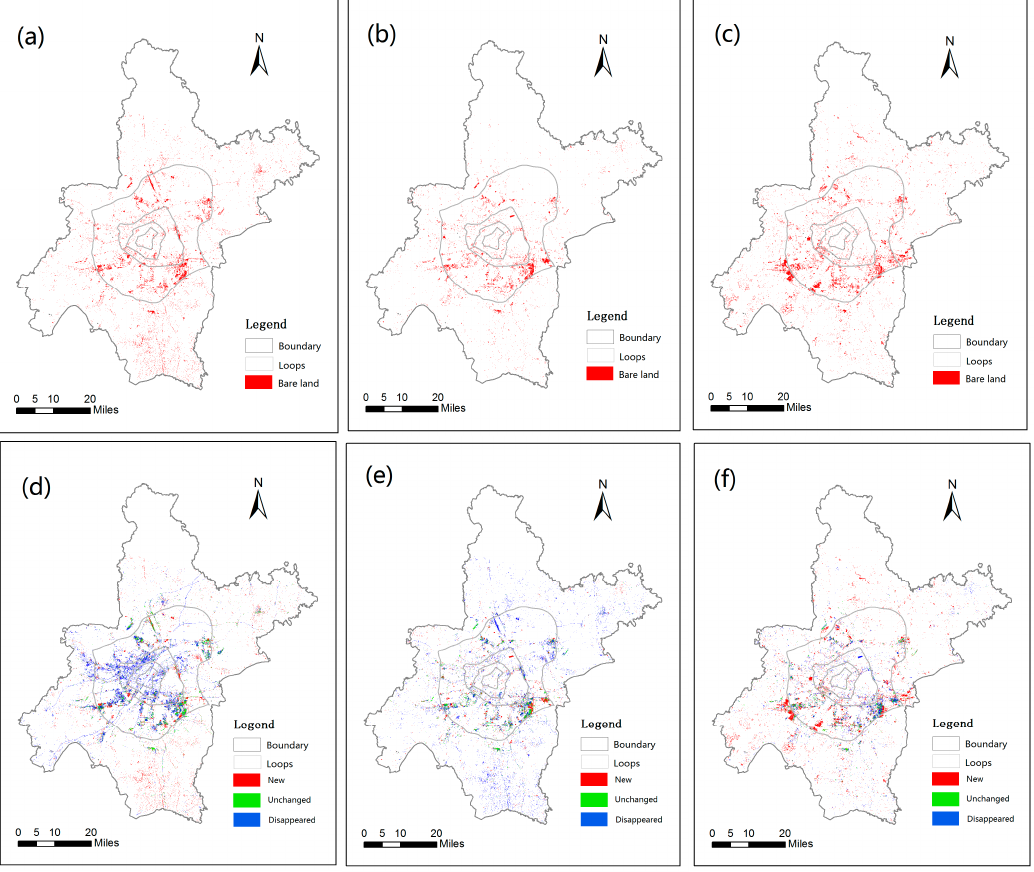
Figure 8. Inter-annual changes of the bare land. ( a ) bare land map in 2009; ( b ) bare land map in 2011; ( c ) bare land map in 2013; ( d ) the 2007–2009 change; ( e ) the 2009–2011 change, and ( f ) the 2011–2013 change. Table 3. The distribution of bare lands (km 2 ).